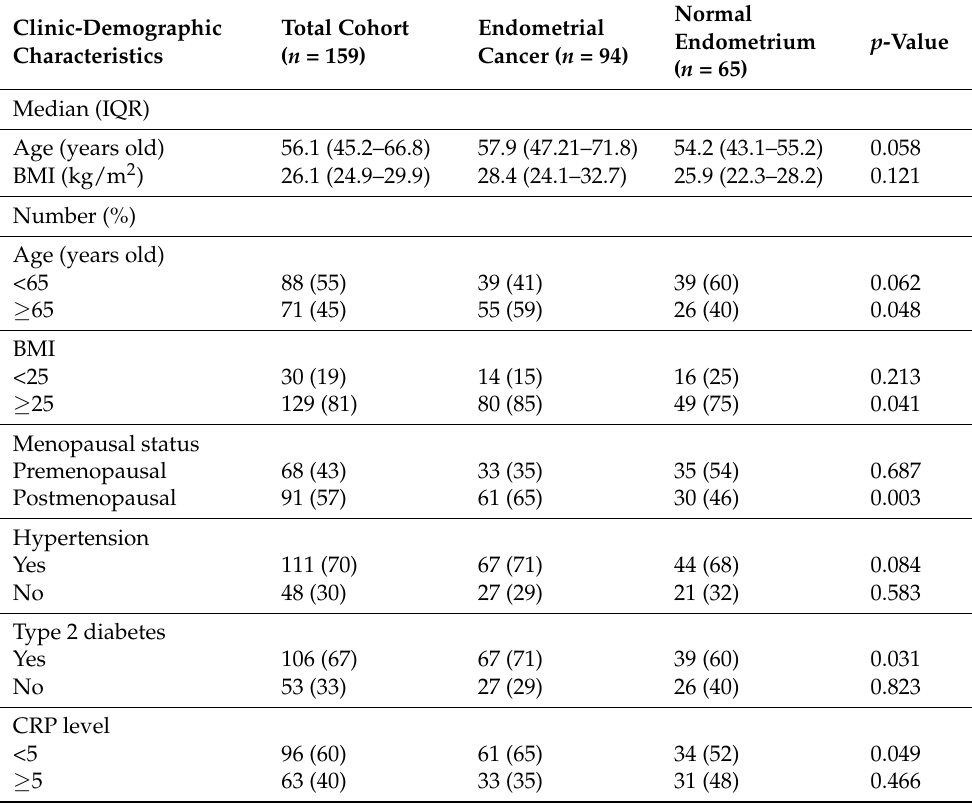
Table 2. Characteristics of patients including clinical and demographic